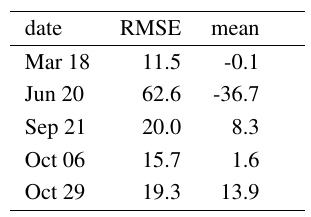
Table 2: Comparison of lidar based DSM and sUAS derived DSMs, RMSE – root-mean-square error [cm], mean – mean difference between lidar DSM and sUAS DSM [cm],